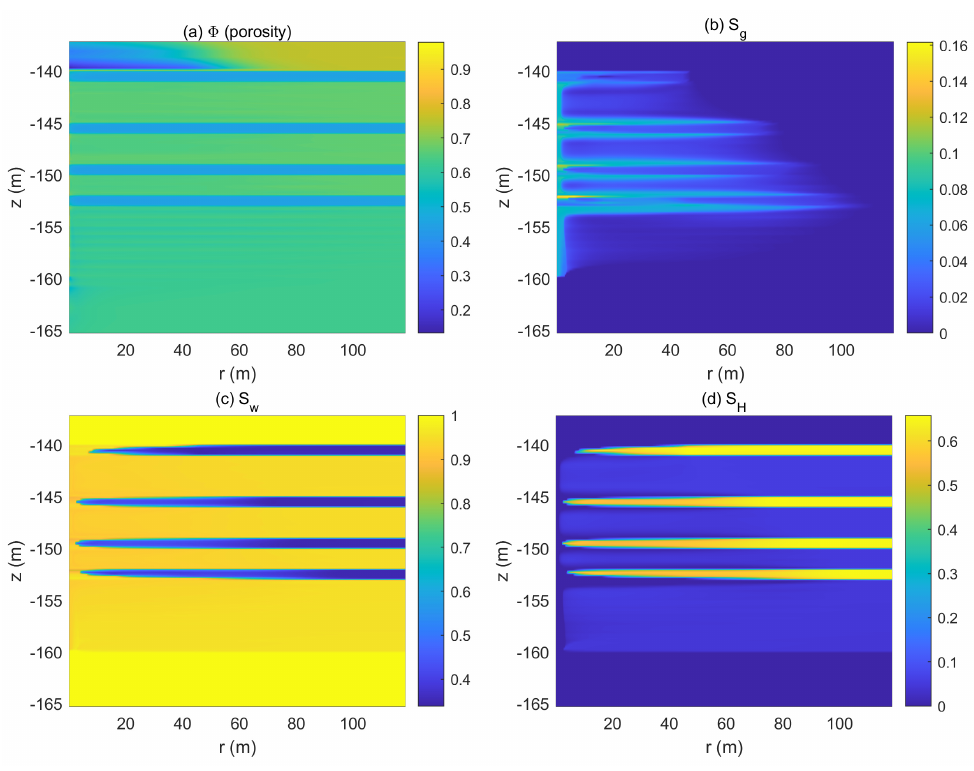
Figure 7. Porosity and saturations of gas, water, and hydrate after 154 days.